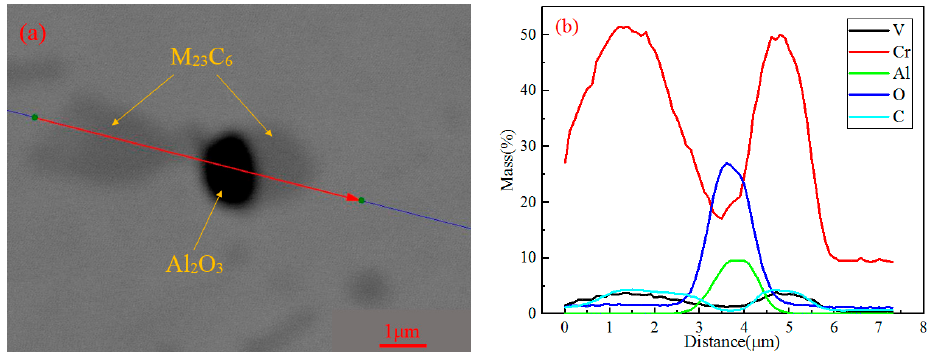
Figure 9. EPMA profiles obtained across carbides and oxides of sample B: ( a ) measurement path; ( b ) V, Cr, Al, O, and C.